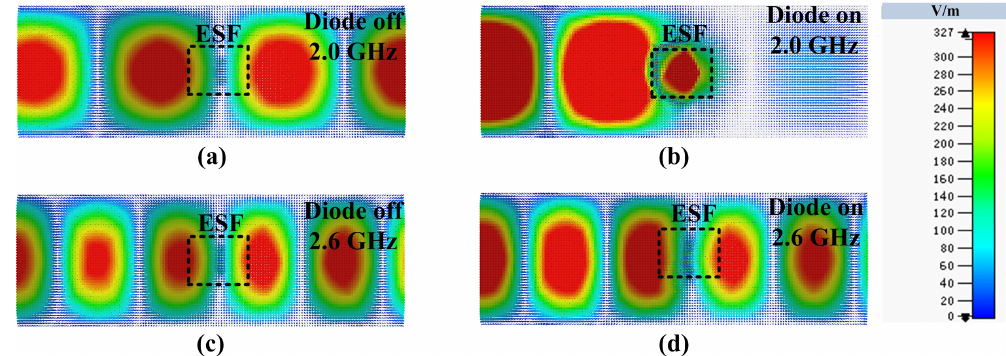
Figure 6. Electric field distributions at condition of diode ( a ) off and ( b ) on at 2.0 GHz, diode ( c ) off and ( d ) on at 2.6 GHz.